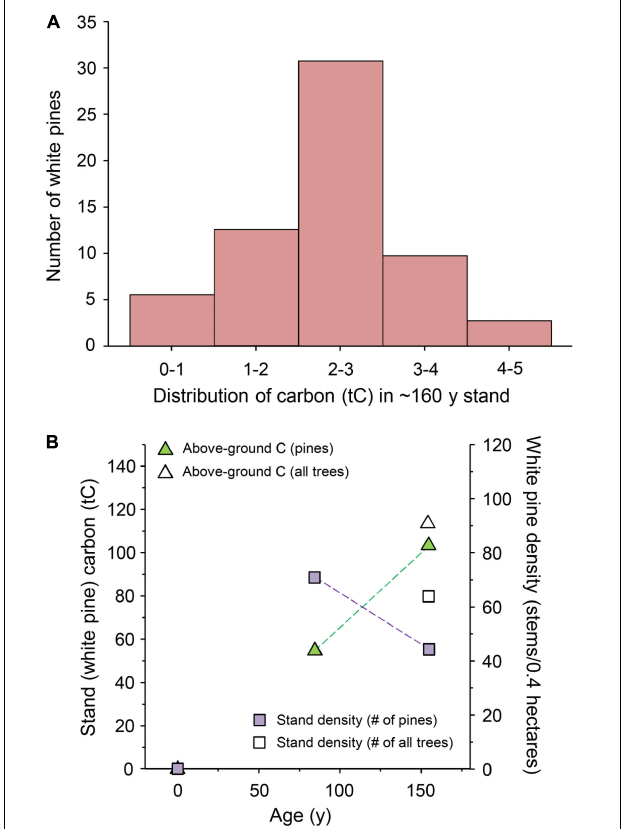
FIGURE 3 | Carbon distribution, stand density and cumulative carbon in predominantly eastern white pine stands at ∼ 80 and 160 years. These two stands were regrown from land previously used as pasture (i.e., not recovering from a harvest at time zero). (A) Distribution of above-ground carbon (tC) among 76 eastern white pines of different sizes in the full TOP stand at ∼ 160 years old. The majority contained 1–3 tC. (B) Stand density and above-ground carbon measured directly on site in a research acre of eastern white pine at ∼ 80 and 160 years. Stand density (# of stems) declined while above-ground carbon increased. The older stand includes some non-pine species that added to the number of stems and total carbon (open